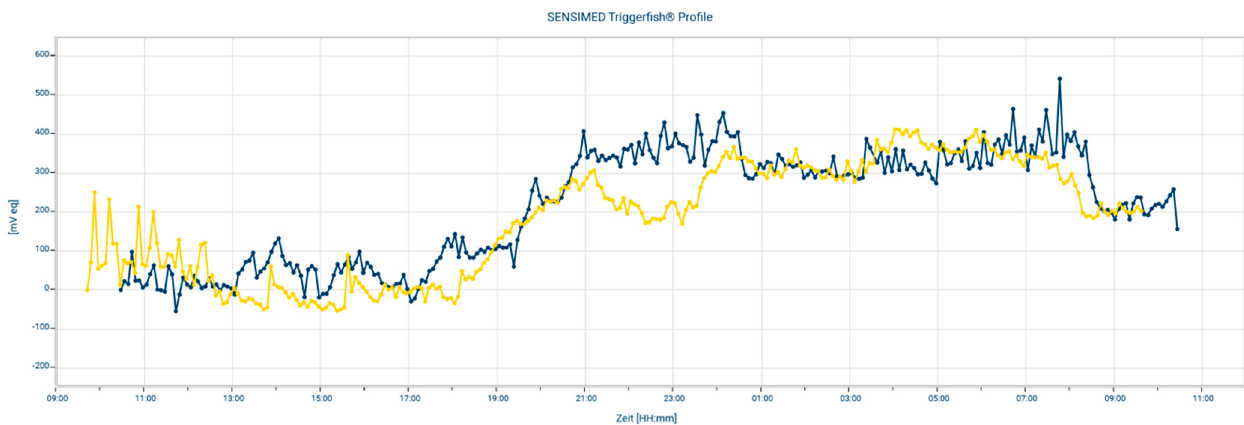
Figure 2. A measurement example overlays a 24 h measurement before and after the surgery.